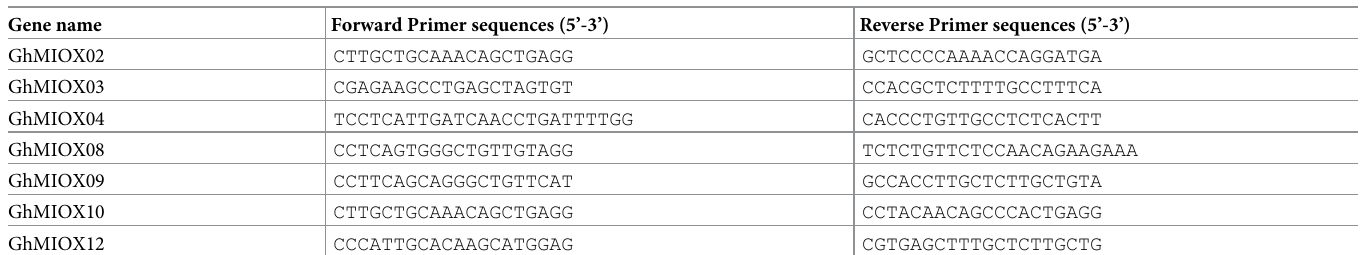
Table 1. The specific primers for qRT-PCR of G . hirsutum MIOX